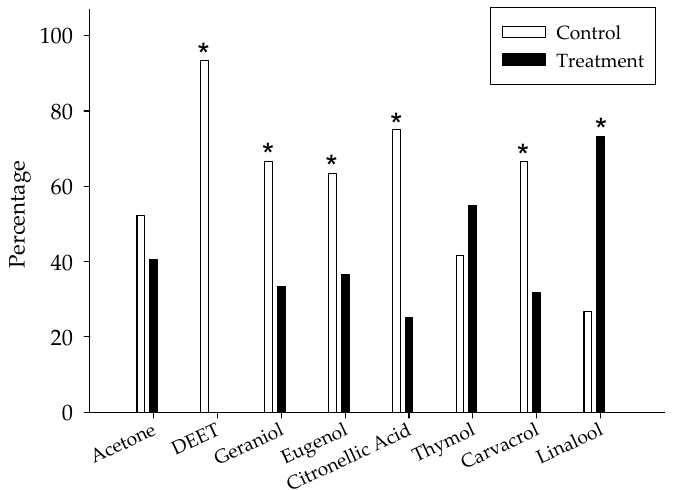
Figure 3. Bed bug preference (five females, five males) for a paper tent impregnated with essential oil constituents (1%) aged for 24 h vs. a tent impregnated with acetone. After a 14-h test period, the number of insects resting on any of the treatment harborages or wandering on the arena was recorded. * Significant differences between control and EOC-treated tents ( p < 0.05; N = 6).